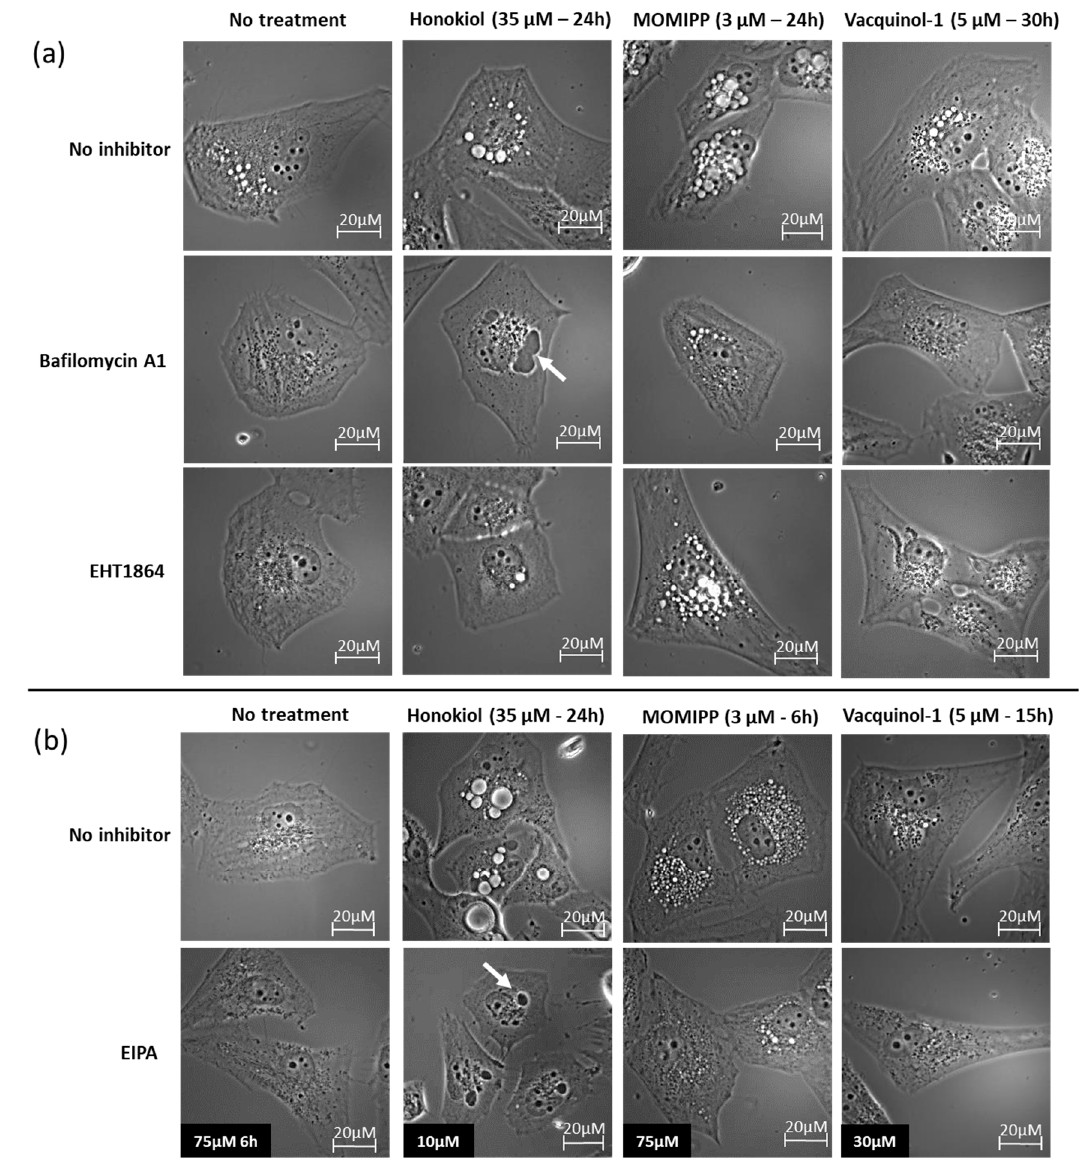
Figure 6. Effects of various inhibitors on vacuole formation following honokiol, vacquinol-1, and MOMIPP treatment in U373 cells. Representative brightfield illustrations of U373 cells treated with or without the inhibitors are as follows: ( a ) pre-treated 1 h with bafilomycin A1 (100 nM) before honokiol (35 µM), MOMIPP (3 µM) or vacquinol-1 (5 µM) treatment, co-treatment with EHT1864 (25 µM) and the compound. Bafilomycin A1 inhibits the vacuoles induced by each compound but not ER-derived dark dense vacuoles induced by honokiol (white arrow). EHT1864 slightly inhibits vacuolization induced by honokiol and vacquinol-1 but not for vacuolization induced by MOMIPP. ( b ) Cells were co-treated with EIPA (10, 30 and 75 µM) and each compound. EIPA inhibits the vacuoles induced by each compound except the ER-derived dark dense vacuoles induced by honokiol (white arrow; similar than bafilomycin A1 effects). Each experiment has been conducted at least twice in triplicate.